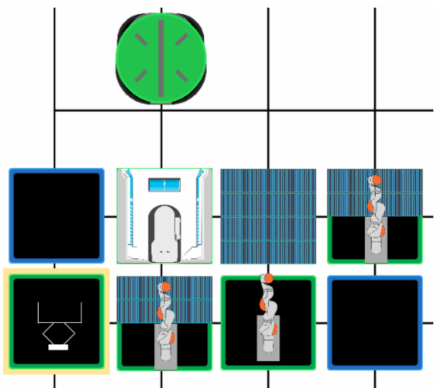
Figure 11. Power supply using platforms connected to the traction line (yellow border).